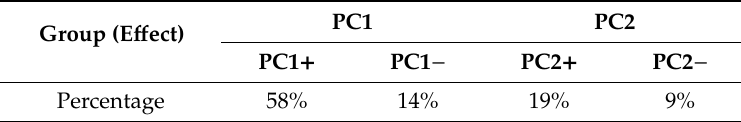
Table 2. Percentages of the first two principal components (PC1 and PC2) summarizing the winter wheat yield responses to the